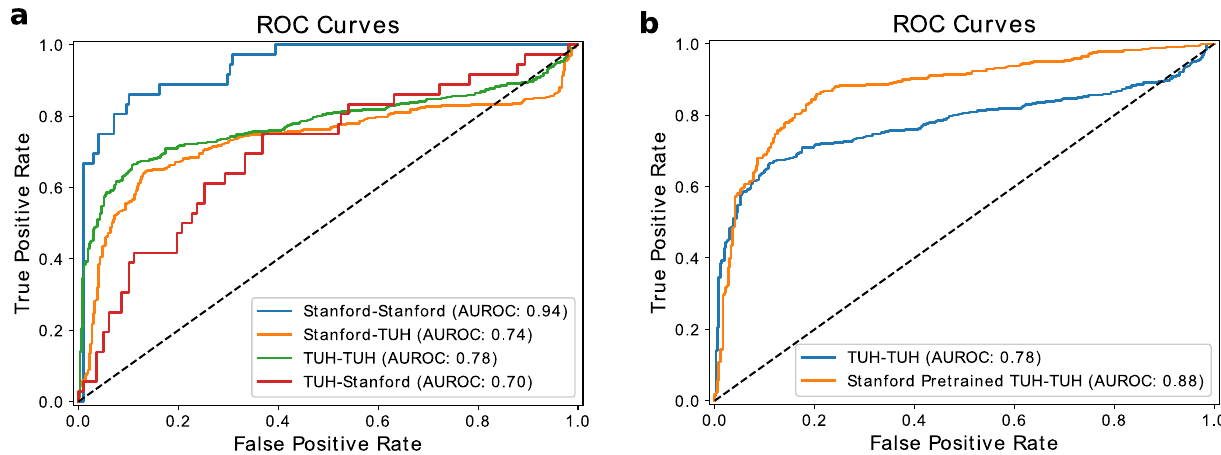
Fig. 5 Generalization and transfer learning results across institutions. a We train models using both Stanford and TUH datasets, and evaluate on the test set from each institution. We show median ROC curves obtained from 5 runs of each model. X – Y stands for trained on X and evaluated on Y. b We fi ne-tune our model pre-trained on the large weakly labeled Stanford dataset using the TUH dataset. We compare the median ROC curves with and without